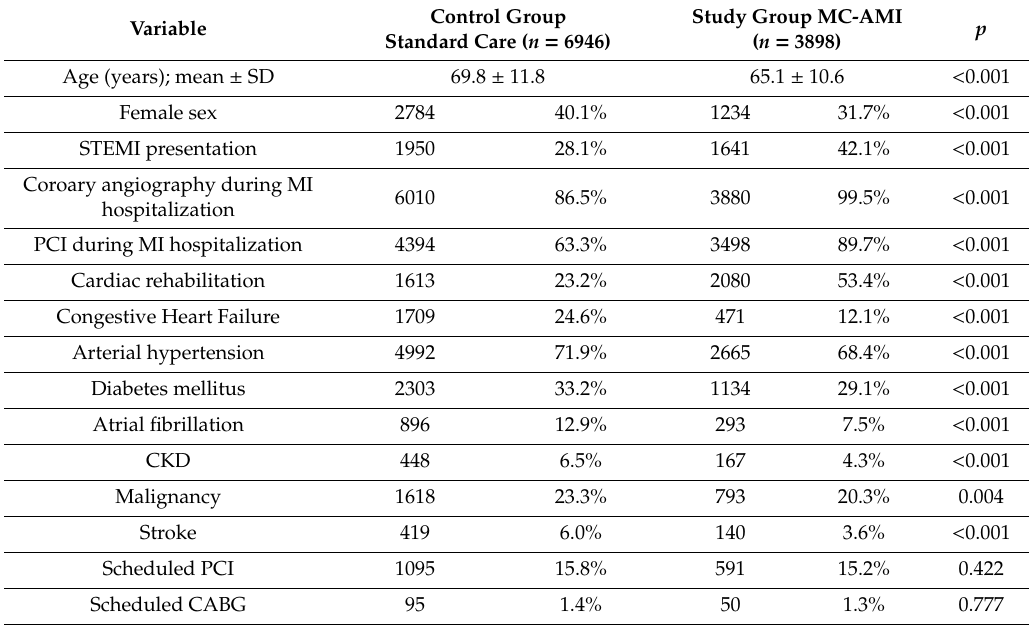
Table 1. Baseline characteristics in unmatched study groups ( n =